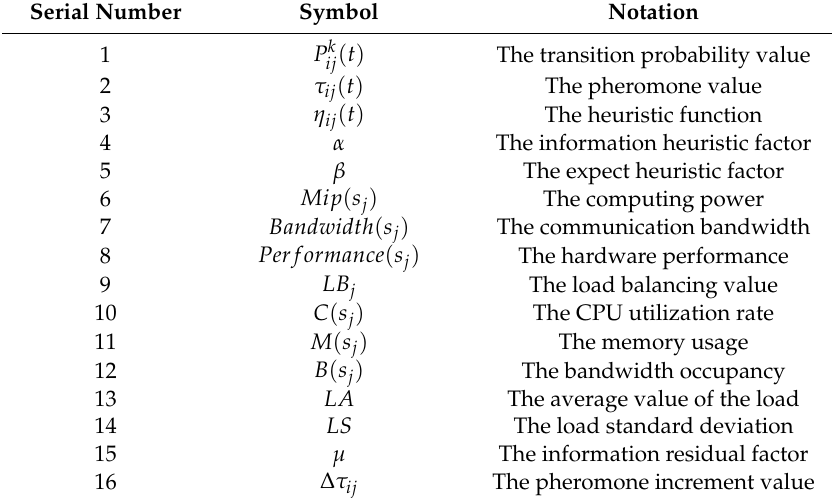
Table 2. The mathematical symbols